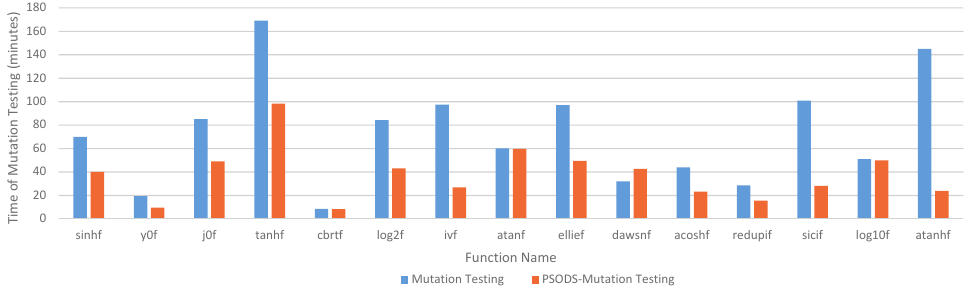
Figure 8. Run Time of Mutation Testing and PSODS-Mutation